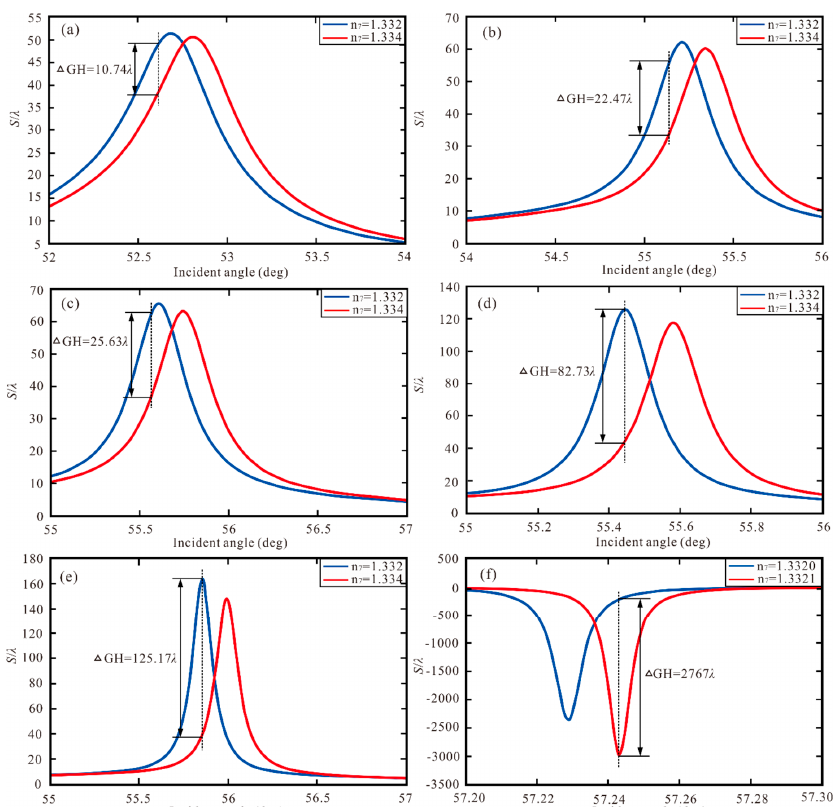
Figure 7. ( a – e ) GH shift with Structure I/Structure II/Structure III/Structure IV/Structure V with the Δ n 7 = 0.002, ( f ) GH shift with Structure VI with the Δ n 7 = 0.0001.